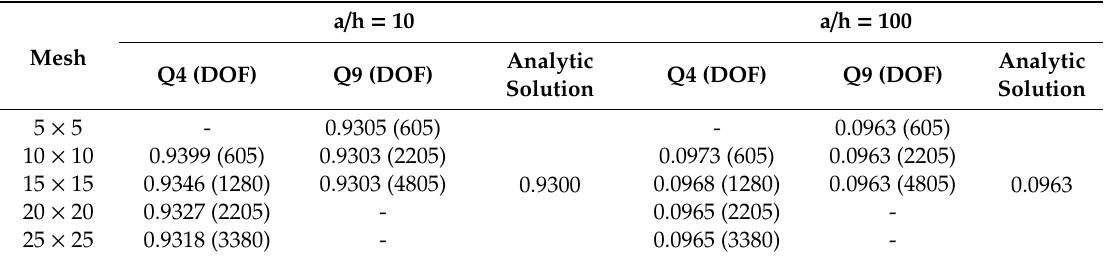
Table 3. Convergence study for the first natural frequency of a square plate.